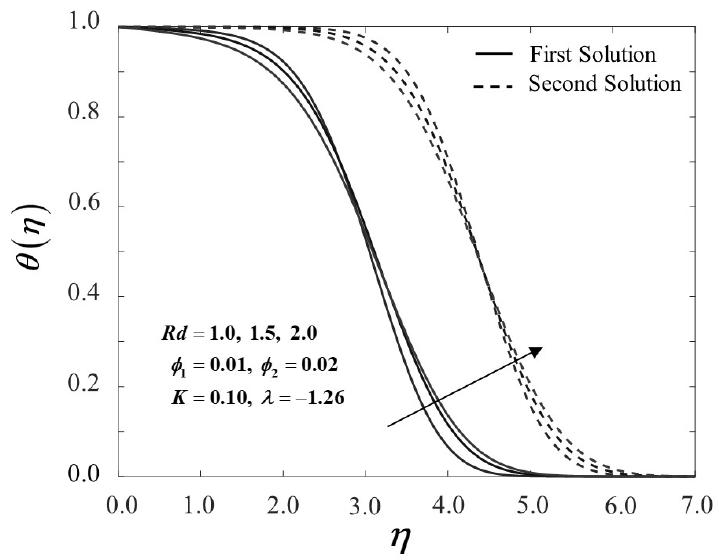
Figure 10. θ ( η ) towards η by assorted Rd .